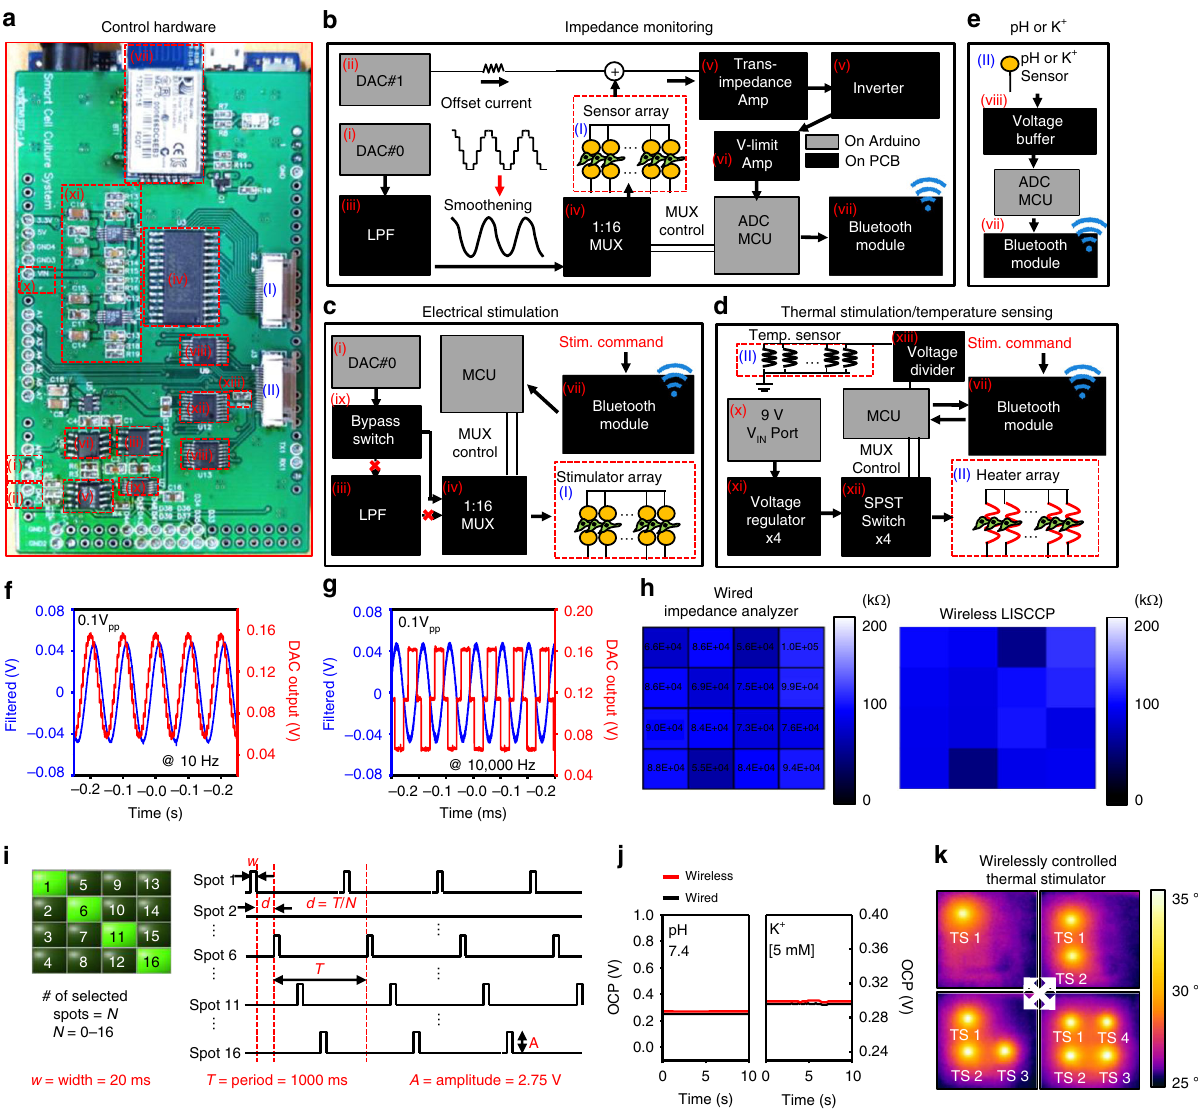
Fig. 3 Design of a wireless system and control algorithm. a Photograph of the data acquisition hardware. b – e Control fl ow chart of the impedance sensing ( b ), electrical stimulation ( c ), thermal stimulation and temperature sensing ( d ), and pH and K + sensing ( e ). f , g Plots showing the DAC output for impedance measurement (red) and fi ltered signals (blue) of the adjustable frequency range (10 – 10,000Hz). h Comparison of the impedance measurement between wired (left) and wireless (right; screenshot image of the software) recordings. i Plot of electrical stimulations controlled by the user interface software to specify the site of stimulations. j Plots to compare wired and wireless measurements of pH and K + concentrations. k Infrared camera images of the heat generated and controlled by the thermal stimulators (TS) wirelessly. The number of TS to turn on can be